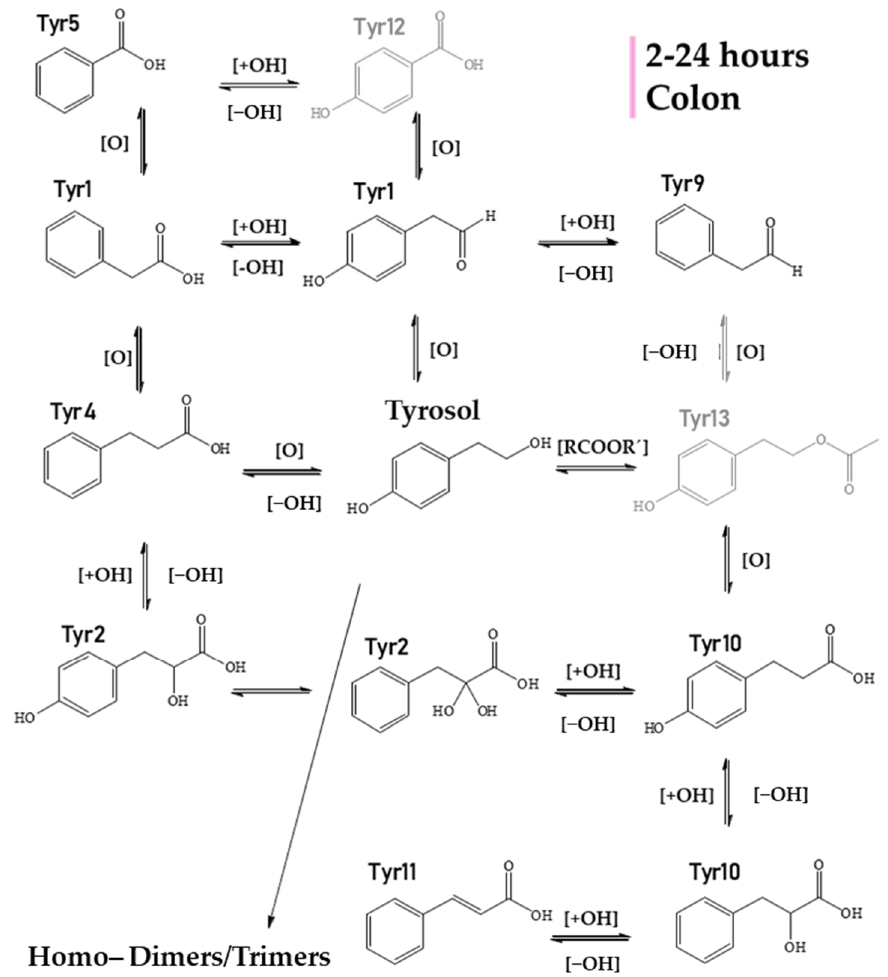
Figure 6. Suggested metabolism pathway of Tyr exposed for 2 to 24 h at colonic conditions (small intestine retentate, fecal slurry, pH: 5.8, anaerobic conditions, T = 37 °C). All metabolites detected (black color) or eliminated (grey color) during 24 h of colonic metabolism.